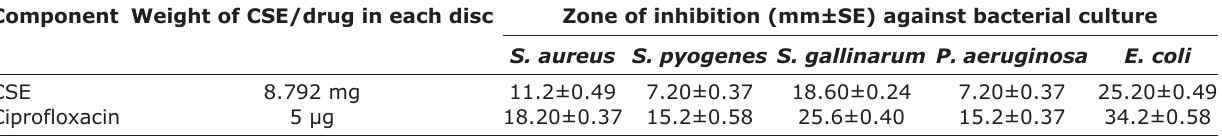
Table-3: Effect of supplementation of CSE on antioxidant activity in broiler birds. Parameter (unit)